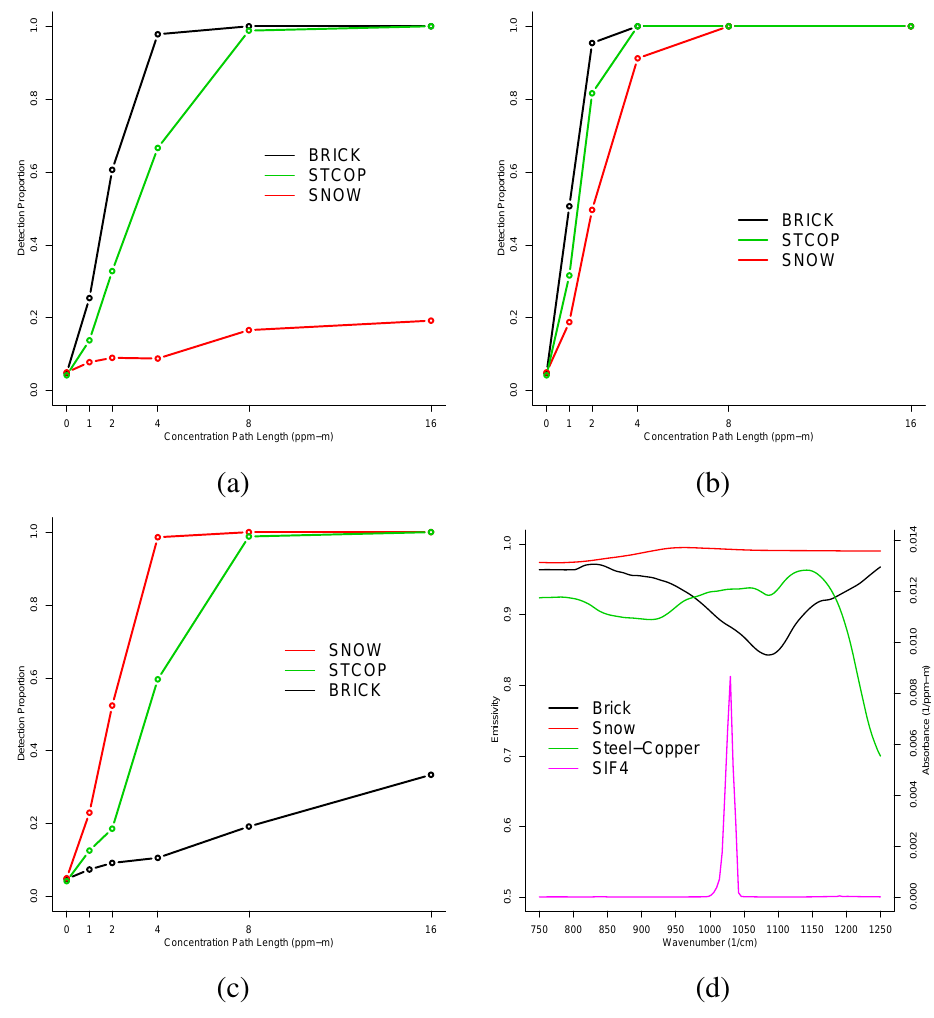
Figure 4. Detection proportions for SiF T = 300 K , (c) T g